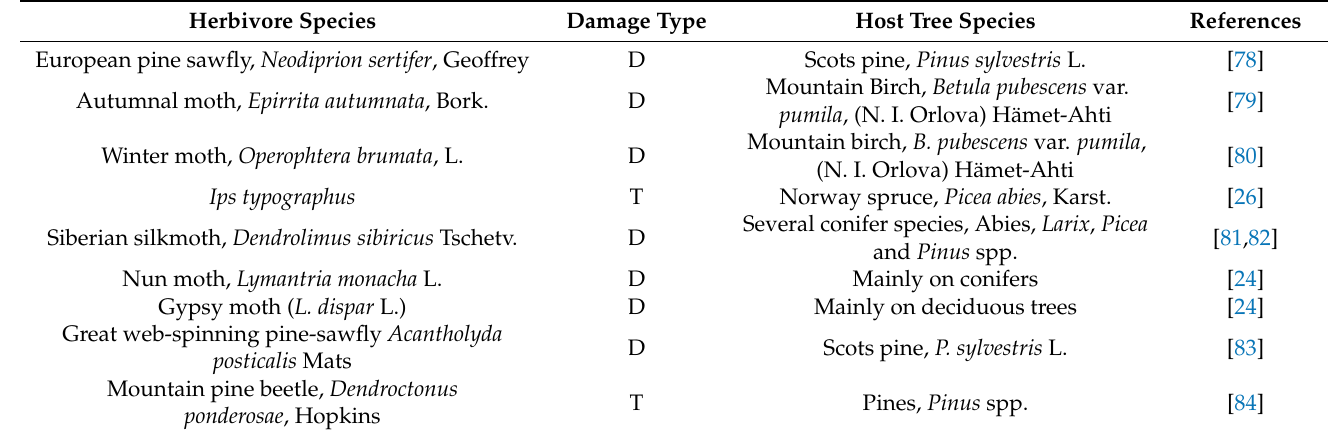
Table 2. Some major defoliating and bark/trunk damaging outbreak species of boreal trees and species showing expansion towards the north under climate warming to date. Damage type; D = defoliator, T = trunk and bark